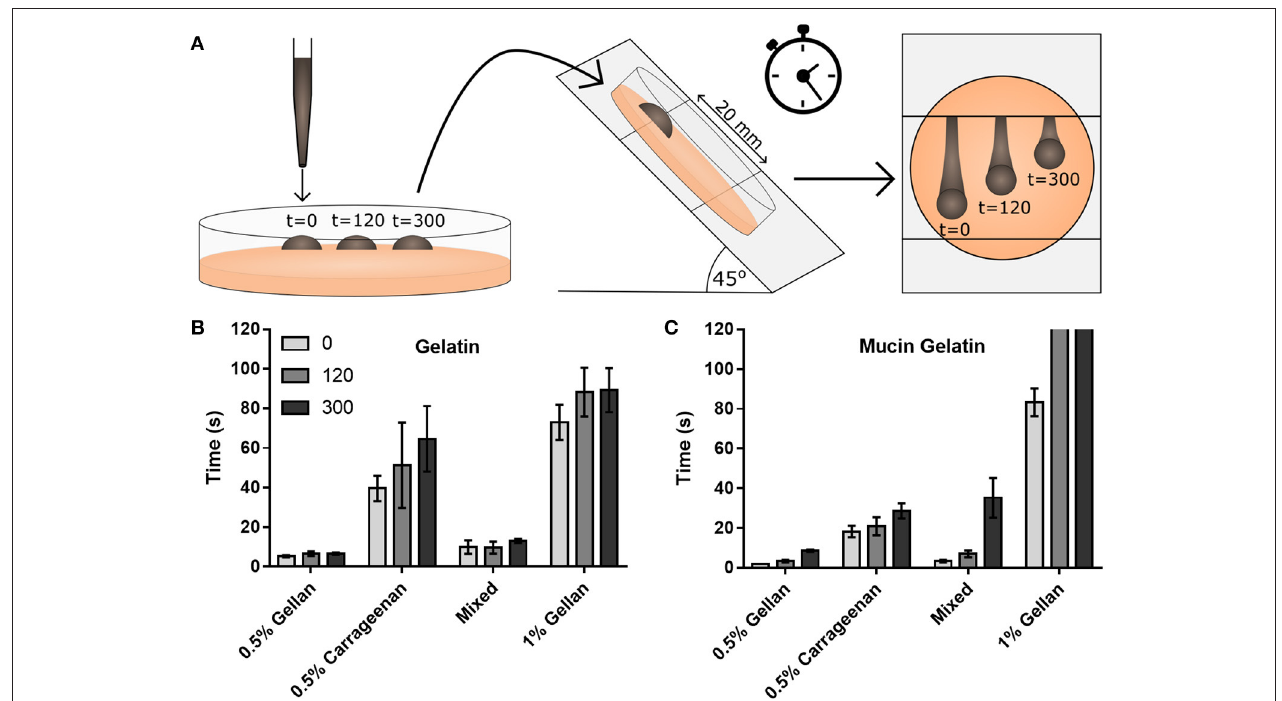
FIGURE 5 | (A) A schematic of the drop flow adhesion study, where drops of formulation are pipetted onto a gelatin only or mucin gelatin surface, allowed to adhere for 0, 120, or 300s, before being tilted at 45 ◦ , and their time to travel 20mm measured. Flow times are displayed for (B) the gelatin only substrate and (C) the mucin functionalized substrate. Note that in (C) , drops of 1% gellan did not flow at all on tilting at 120 and 300s. (B,C) show mean ± SD ( n = 3).